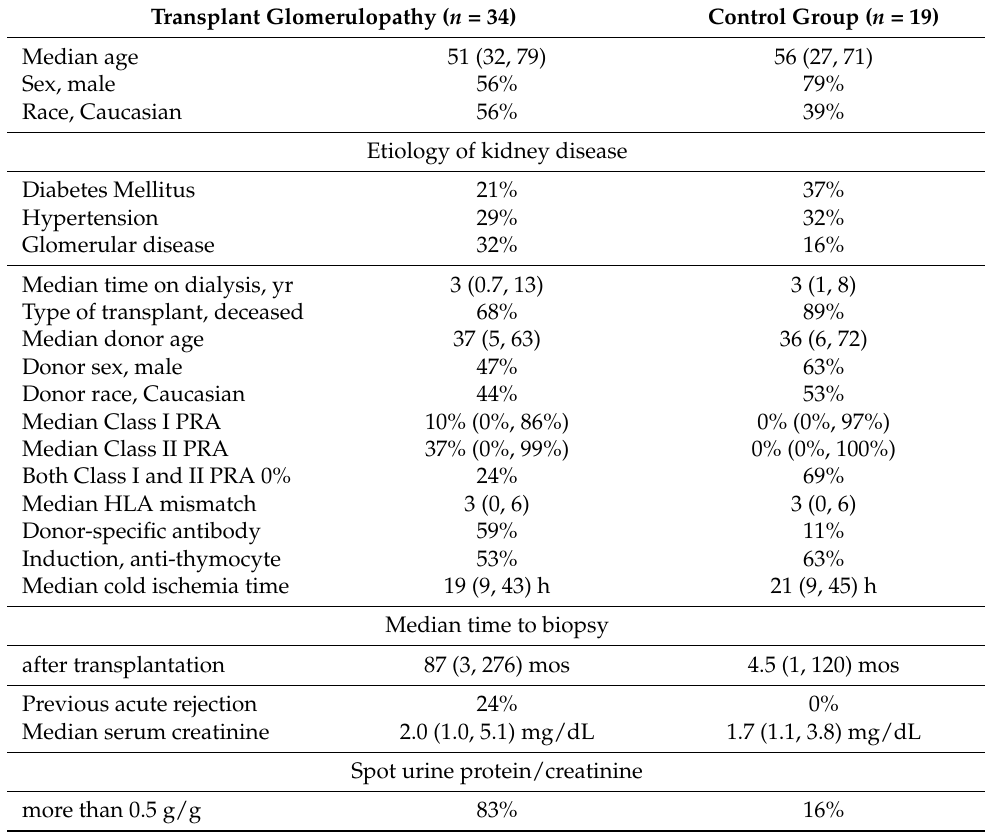
Table 1. Demographic information of the study